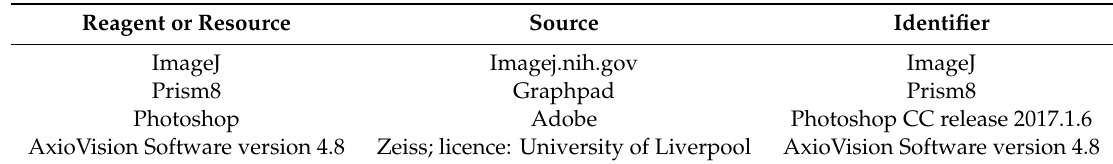
Table A2. Software used in this